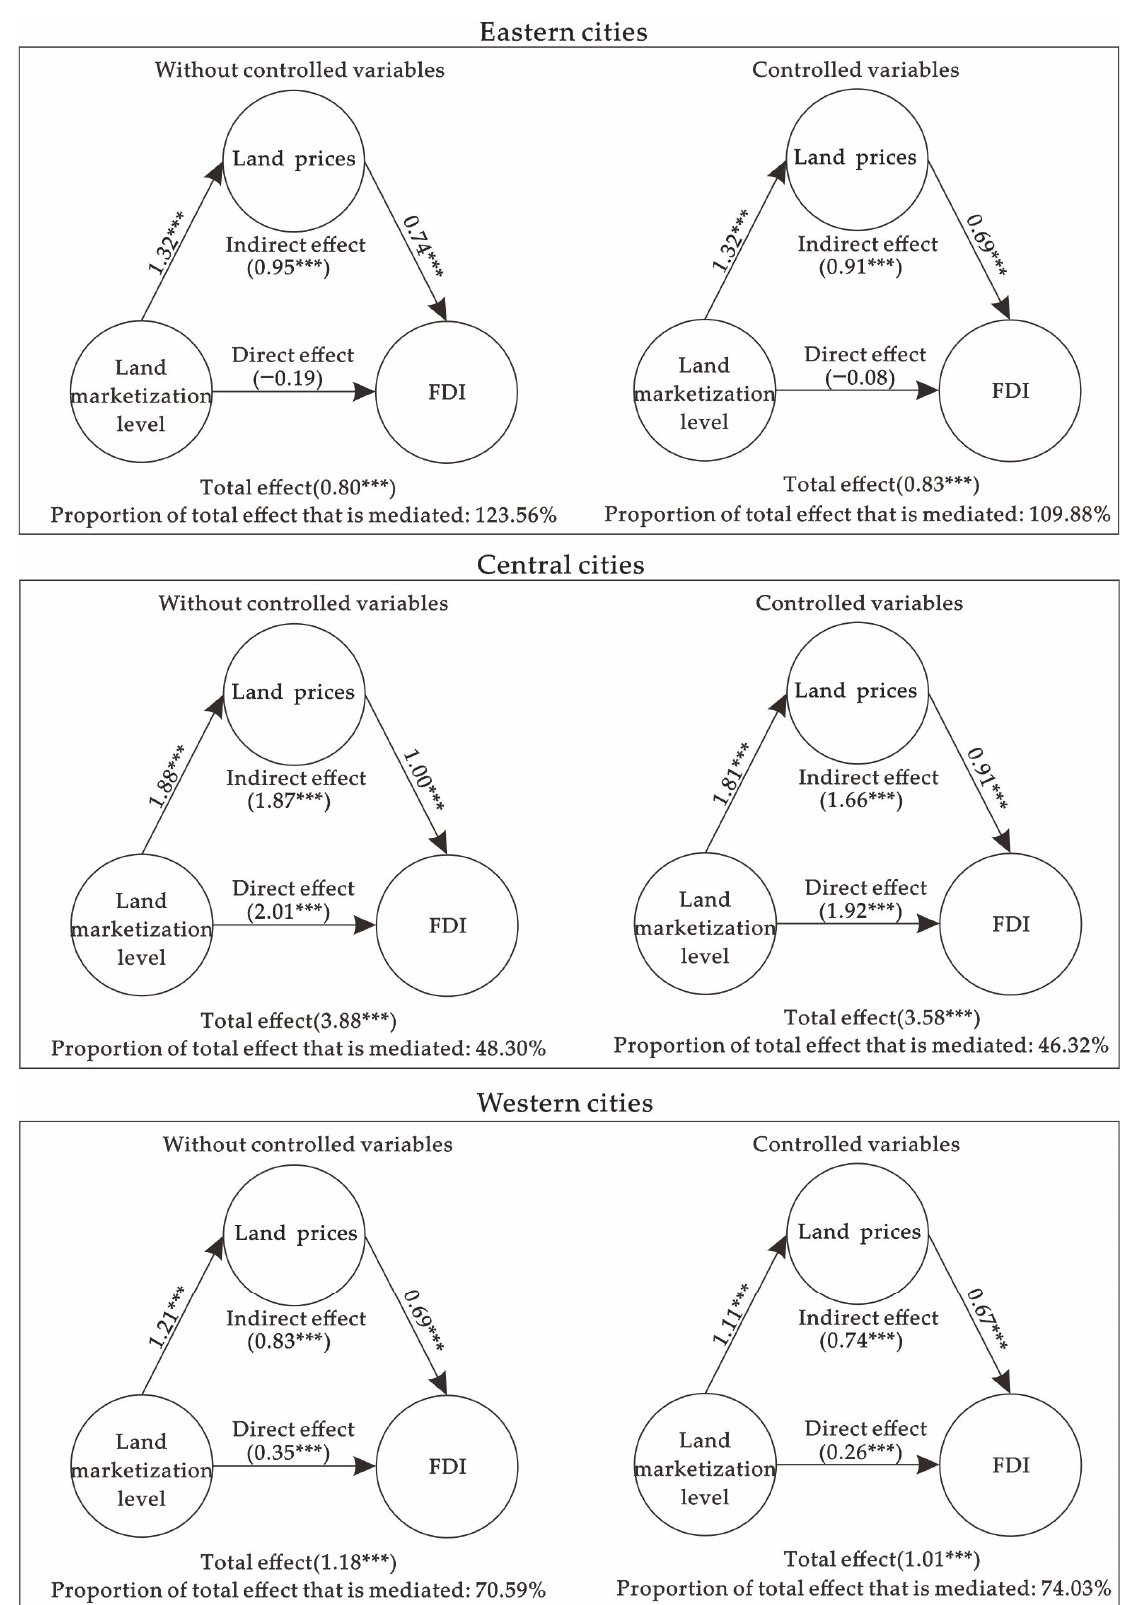
Figure 10. Effect of land marketization level and land prices on FDI in the three economic zones (eastern, western, and central). Note: *** p < 0.01.